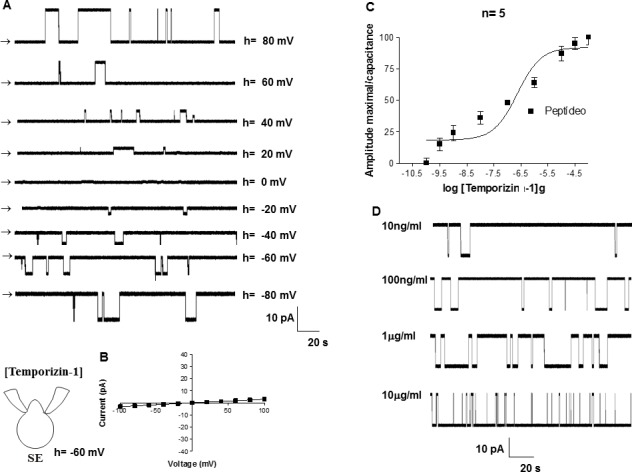
Temporizin-1 induces a macroscopic ionic current in the HEK-293 mammalian cell line.A: Macroscopic ionic currents of a whole-cell patch from HEK-293 cells induced by different temporizin-1 concentrations. The ionic currents (far right) elicited by temporizin-1 are indicated by vertical arrows. The holding potential ranged from +100 mv to -100 mV. B: The mean I-V relations for the whole-cell configuration. C: Whole-cell recordings obtained from HEK-293 cells as a function of the varied temporizin-1 concentrations. D: Single channel recordings at distinct temporizin-1 concentrations. The values represent the means ± SD of six experiments performed on different days.